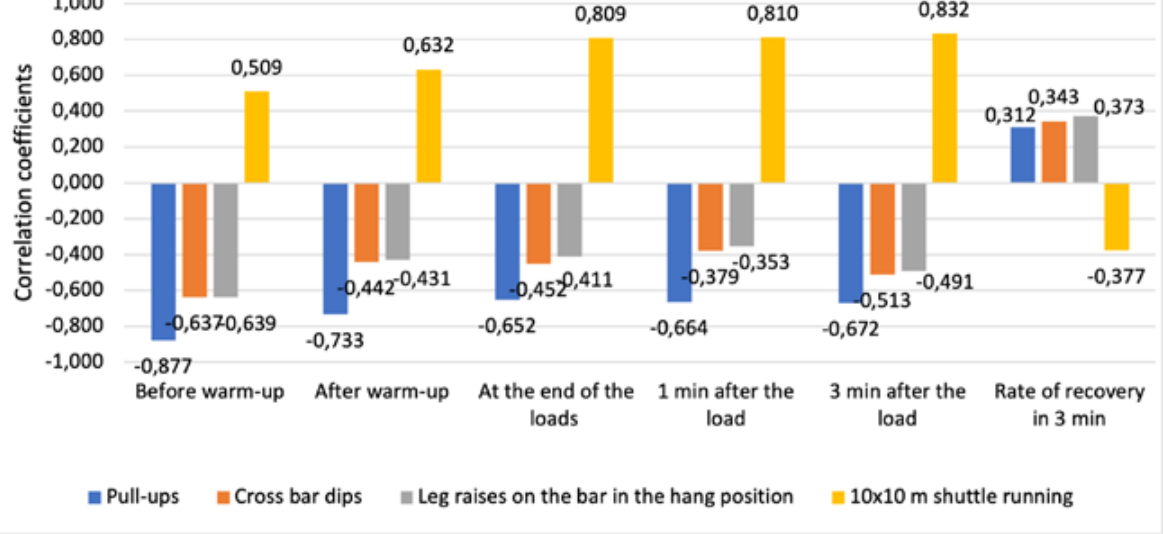
Figure 2. Interrelations of physical fitness parameters of students with HR recorded before, during and in the recovery period after physical load. Note: statistically significant correlations